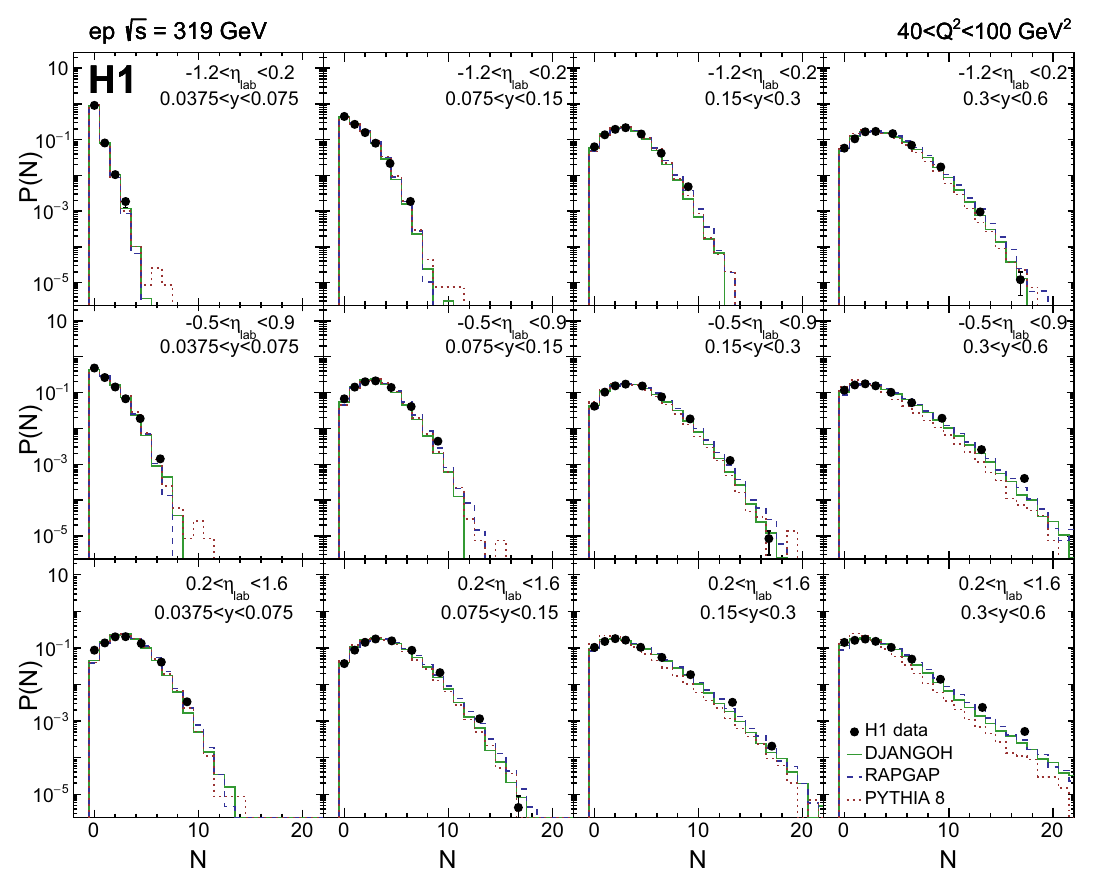
Fig. 6 Charged particle multiplicity distributions P ( N ) as a function cated by the text in the figure. Predictions from DJANGOH, RAPGAP √ s = 319GeVepcollisionsintherange ofthenumberofparticles N at and PYTHIA 8 are also shown. The total uncertainty is denoted by the 40 < Q 2 < 100 GeV 2 . Further phase space restrictions are given in error Table 1. Different panels correspond to different η and y bins, as indi- lab